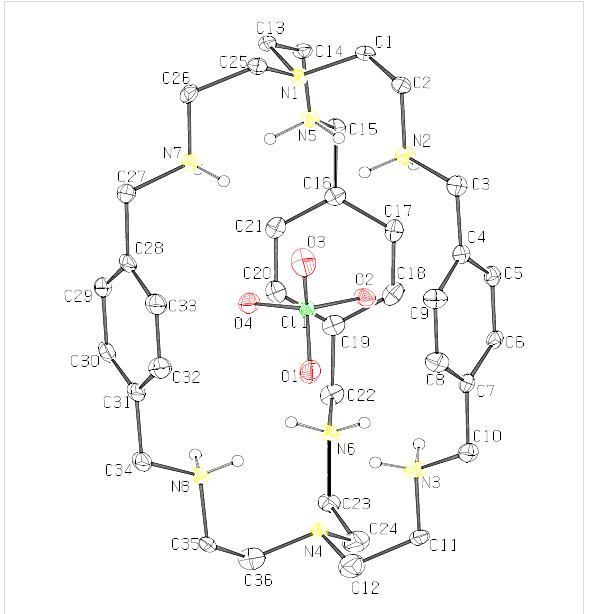
Figure 2: ORTEP diagram of the [H 6 L 1 ] 6+ with encapsulated ClO 4− (40% probability factor for the thermal ellipsoids and hydrogen atoms attached to the protonated nitrogen atoms only are shown for